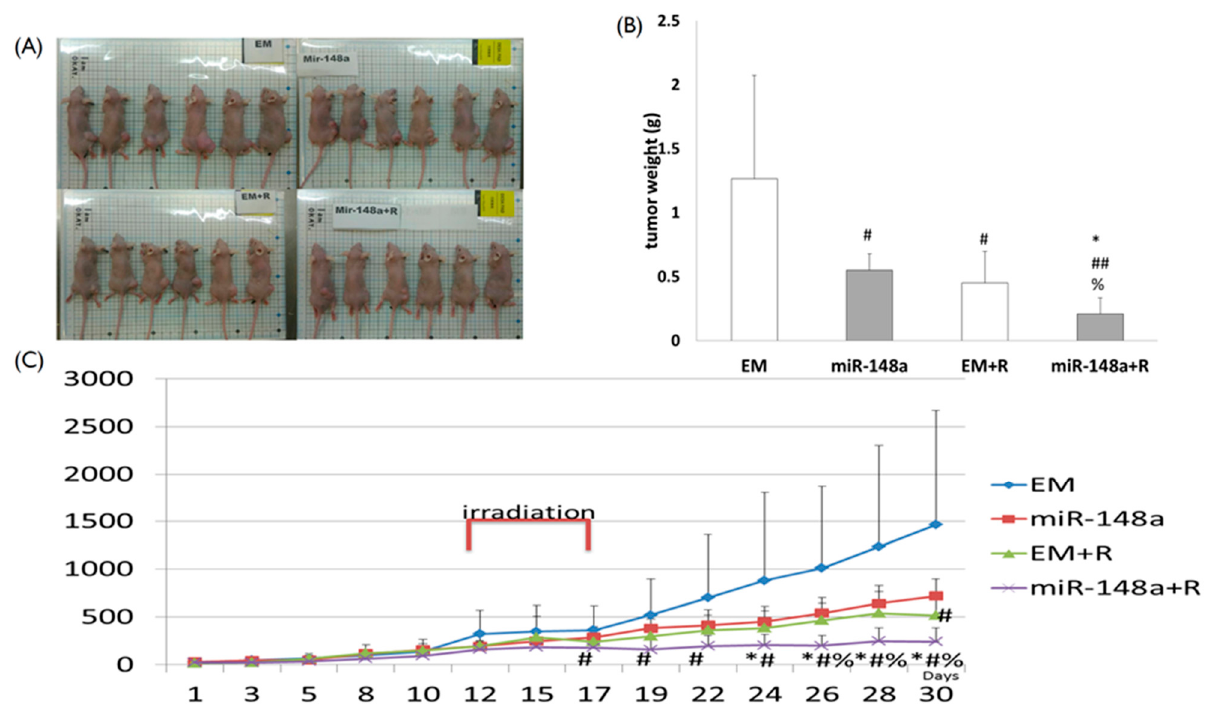
Figure 7. miR ‐ 148a enhanced CRC xenograft response to irradiation. HT29 cells stably transfected with miR ‐ 148a or a negative scrambled pCDH vector (EM) were injected subcutaneously into the right flank of the mice. ( A ) When tumors reached approximately 100 mm 3 in volume, mice were randomly assigned to four groups of six and each tumor lump was treated with 15 Gy in 3 fractions. ( B ) Tumor weights (gram). ( C ) Tumor growth volume (mm 3 ) was measured with a Vernier caliper on the indicated days after inoculation. (N = 6; # p < 0.05, # # p < 0.01 compared with EM; * p < 0.05 compared with EM + R; % p < 0.05 compared with miR148a).